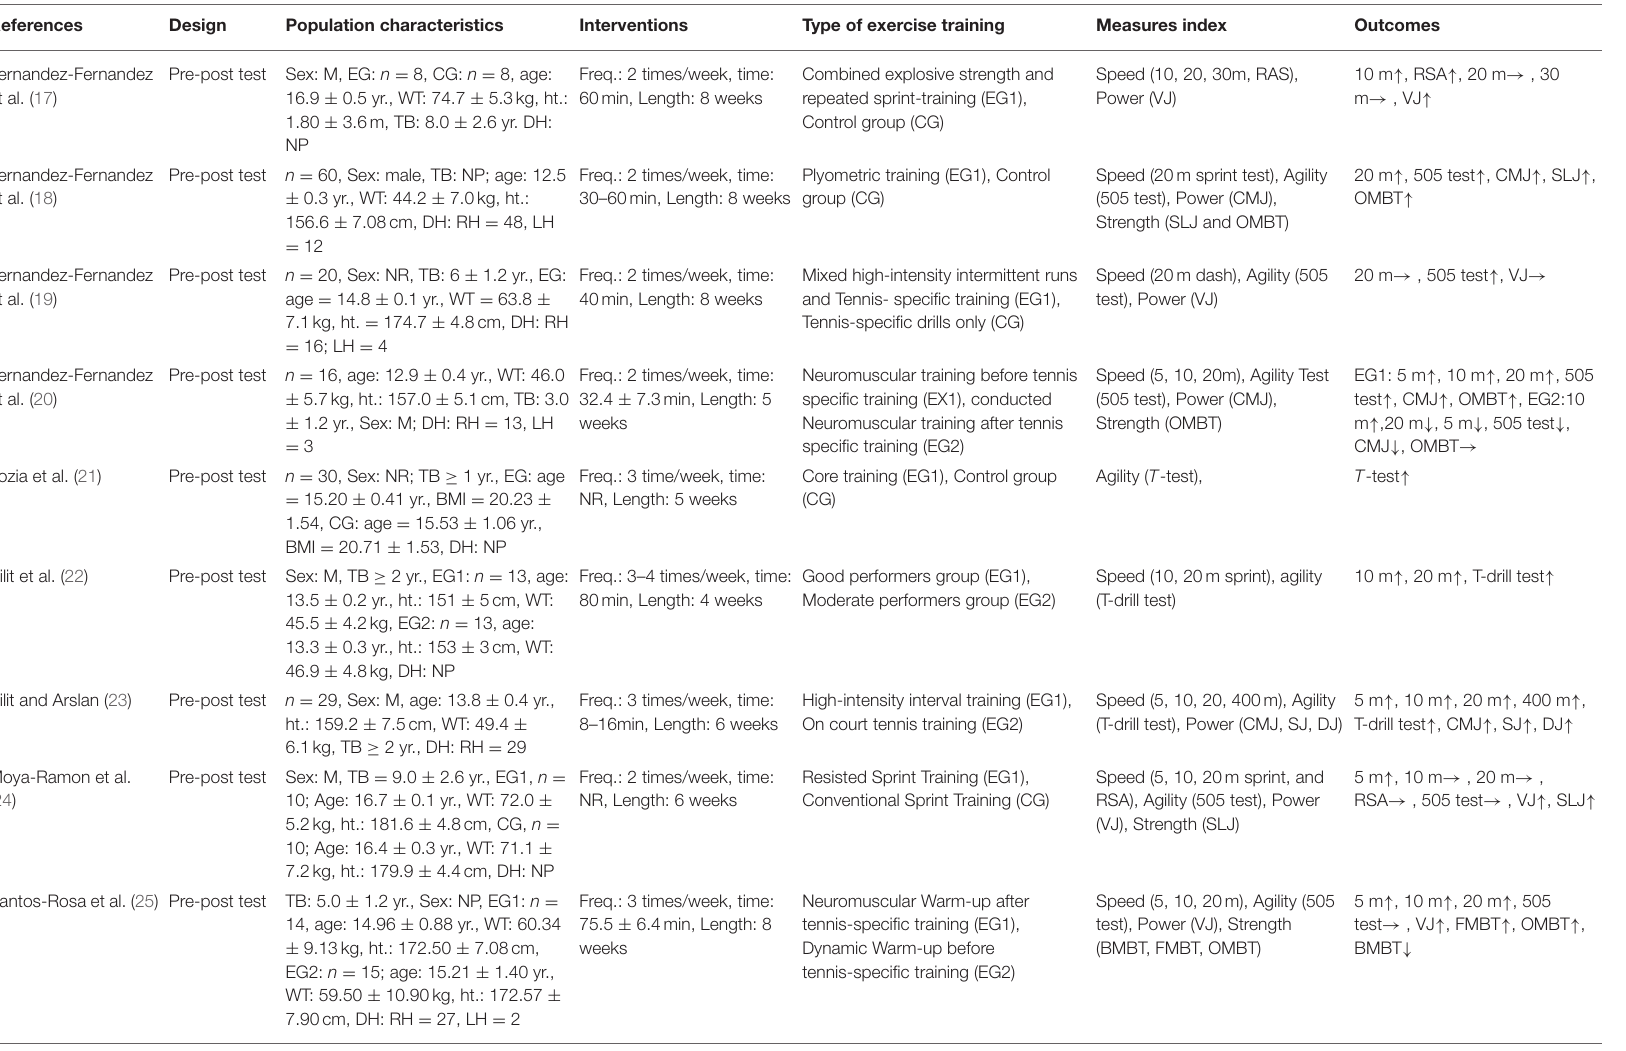
TABLE 2 | Characteristics of included